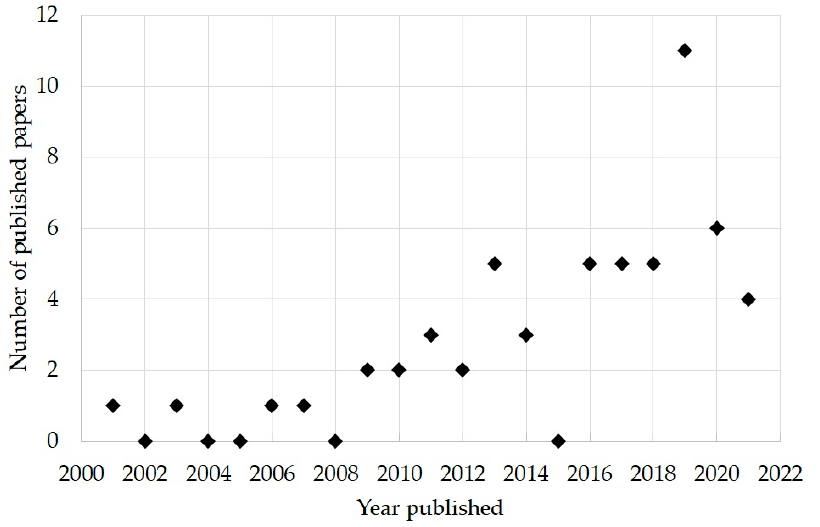
Figure 1. Percentage of publications reporting on clinical outcomes with hypofractionated proton therapy between 2001 and 2021.